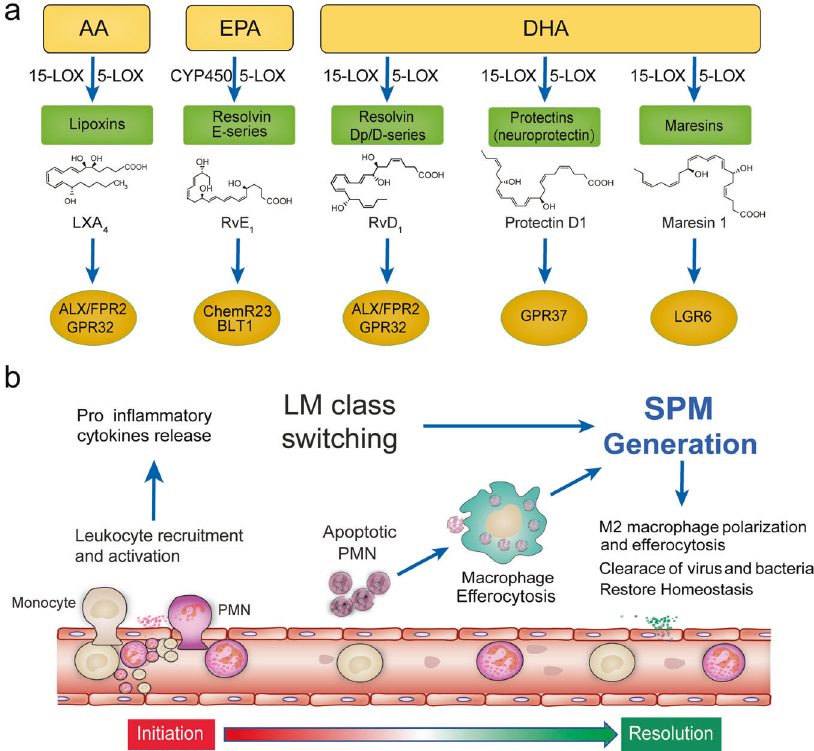
Fig. 1 SPM biosynthesis and their roles in the resolution of in fl ammation. a SPM including lipoxins, E-series resolvins, D-series resolvins, protectins (neuroprotectin D1), and maresins are biosynthesized from arachidonic acid (AA), eicosapentaenoic acid (EPA), and docosahexaenoic acid (DHA). The main structures of these SPM and their receptors are depicted. b Anti-in fl ammatory lipid mediators (LM) class are produced to help restore tissue homeostasis during the resolution of in fl